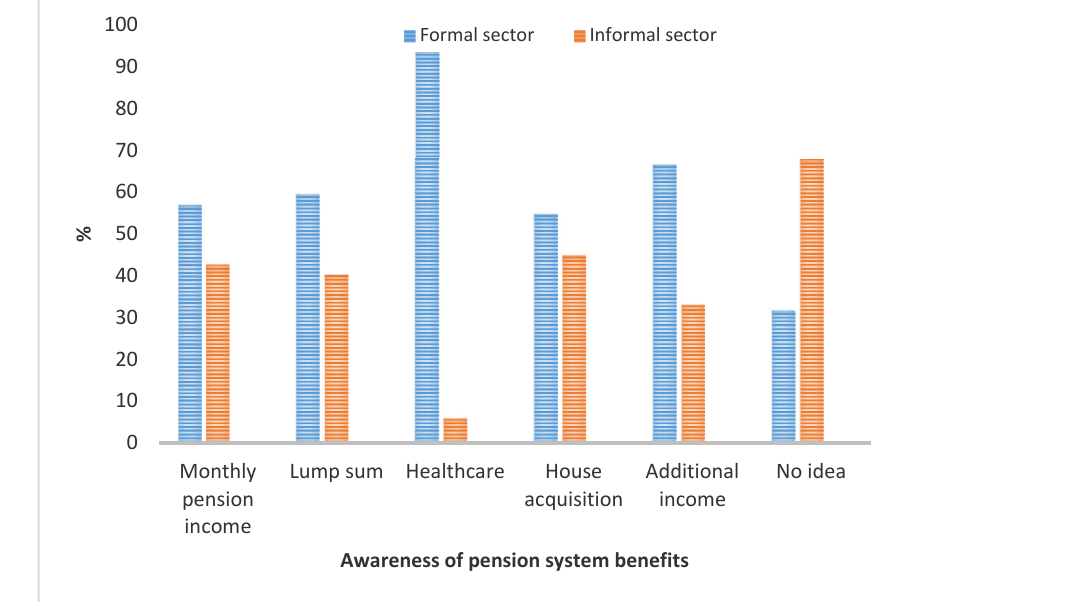
Figure 2. Knowledge of the national pension system’s benefits. Source: Field data.